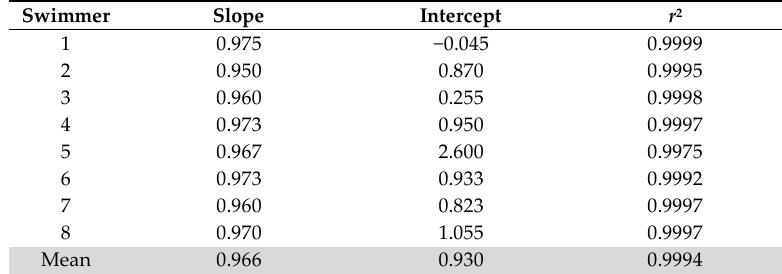
Table 3. Results of the regression analysis for the distance calculated from the IMU measurements vs. tethered velocity meter